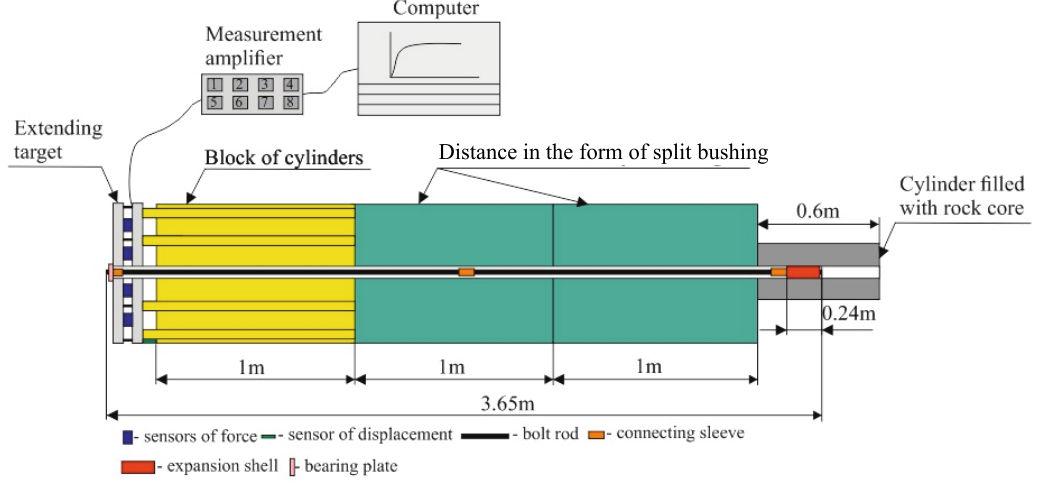
Fig. 7. Block diagram of the hydraulic power supply system of the long expansion